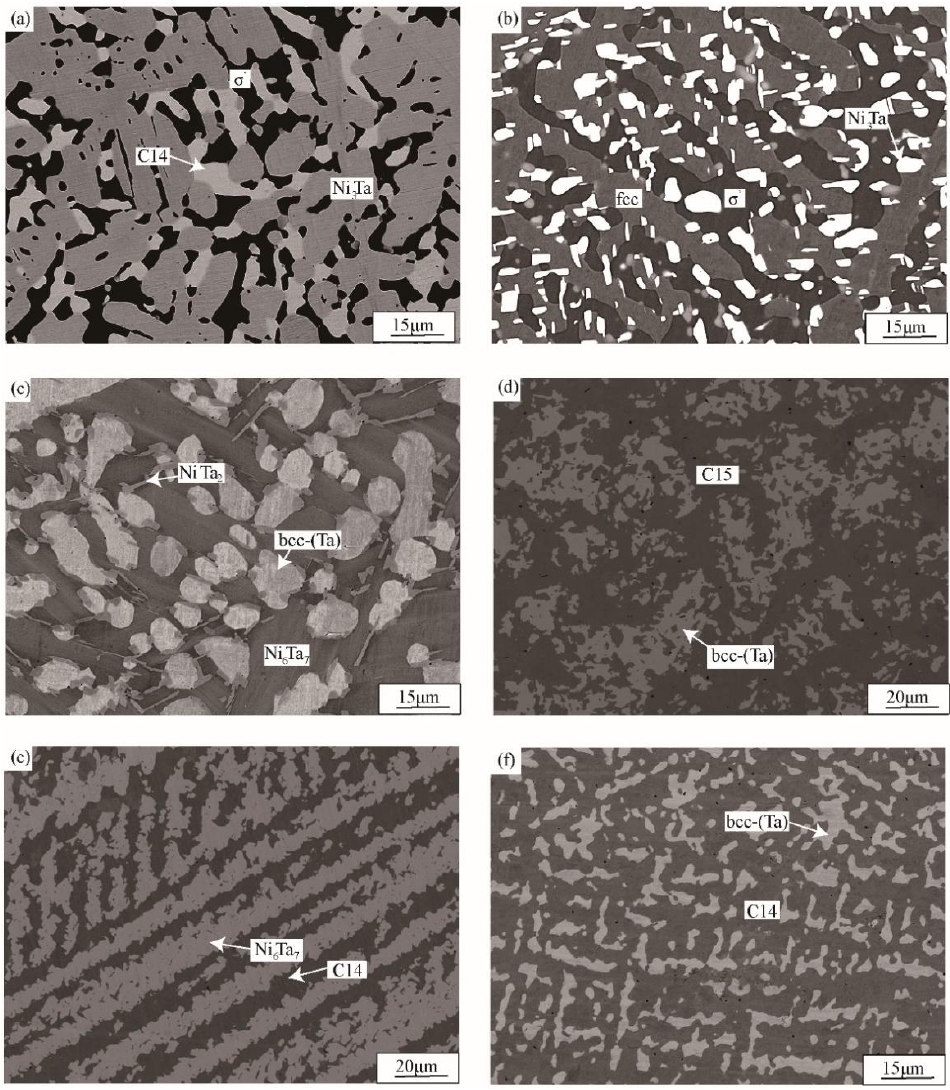
Figure 2. Microstructure of the typical alloys in the Ni-V-Ta system annealed at 1000 °C for 55 days.